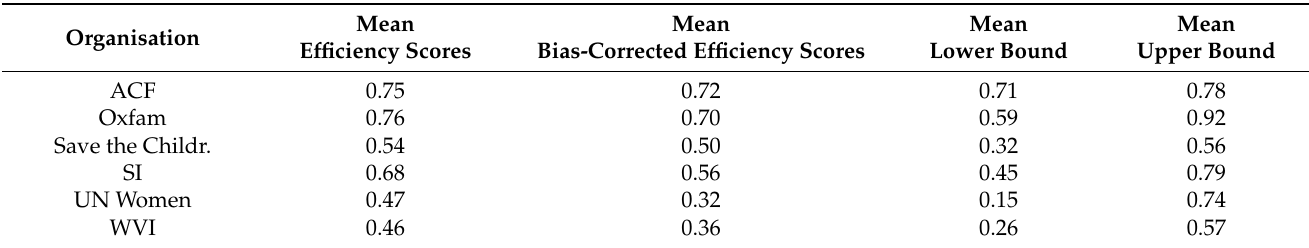
Table 9. Result for bootstrap calculations with B = 1000 iterations.